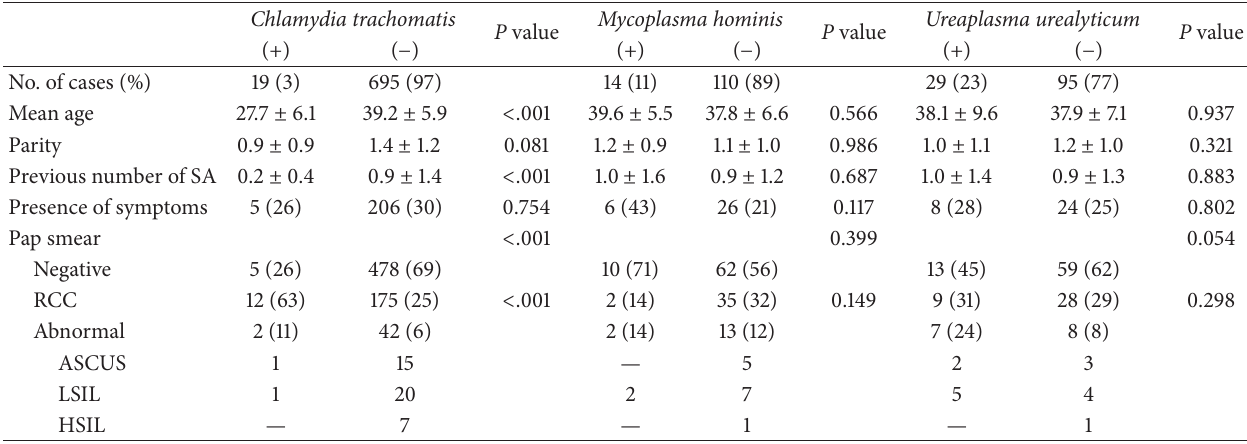
HSIL — 7 — — 1 Values are represented as number (%) and mean ± SD. (+): PCR positive; ( − ): PCR negative; SA: spontaneous abortion; RCC: reactive cellular change; ASCUS: atypical squamous cell-undetermined significance; LSIL: low grade squamous intraepithelial lesion; HSIL: high grade squamous intraepithelial lesion. P values are for comparisons between cases with positive and negative microbiological test